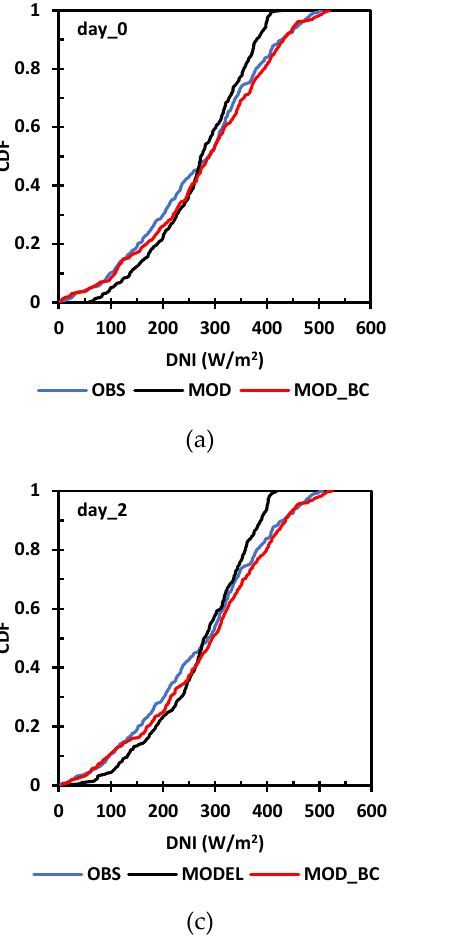
Figure 13. Cumulative distribution functions (CDF) of daily mean DNI grouped by day of forecast, ( a ) Day_0; ( b ) day_1; ( c ) day_2; ( d ) day_3, from 1 August 2018 to 31 July 2019, original forecasts (black line), forecasts after Bias Correction (red line) and observations (blue line).